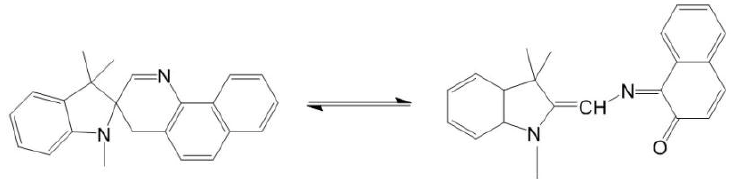
Figure 12. The discoloration mechanism of the photochromic microcapsules.